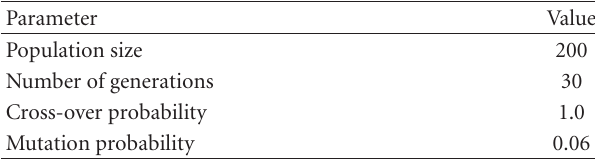
Table 3: Parameters used for EA-based search.